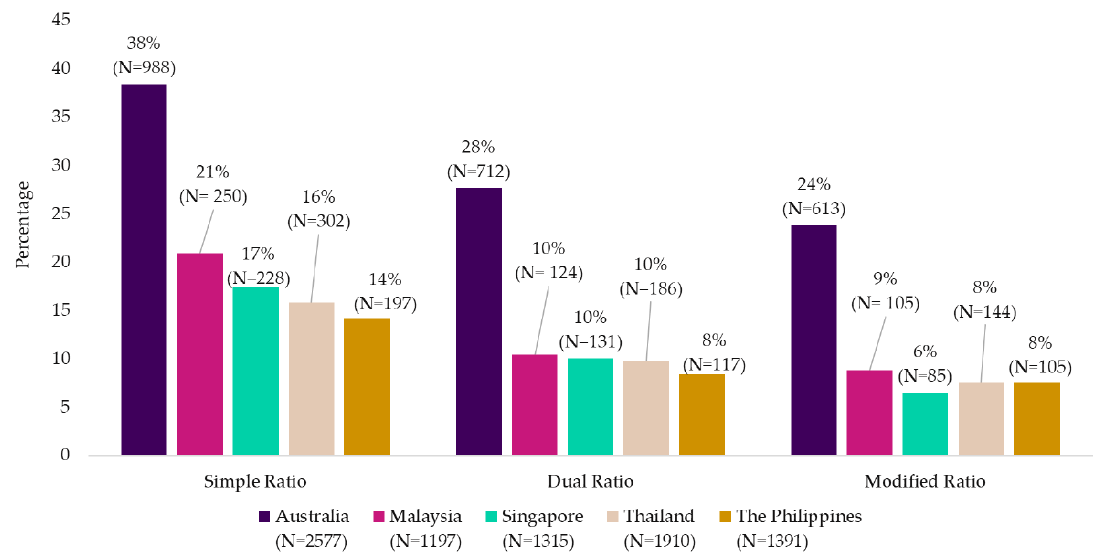
Figure 3. Comparison of the percentage of carbohydrate-based packaged foods and beverages from the Mintel Database that meet each metric across the five countries ( n = 8390).